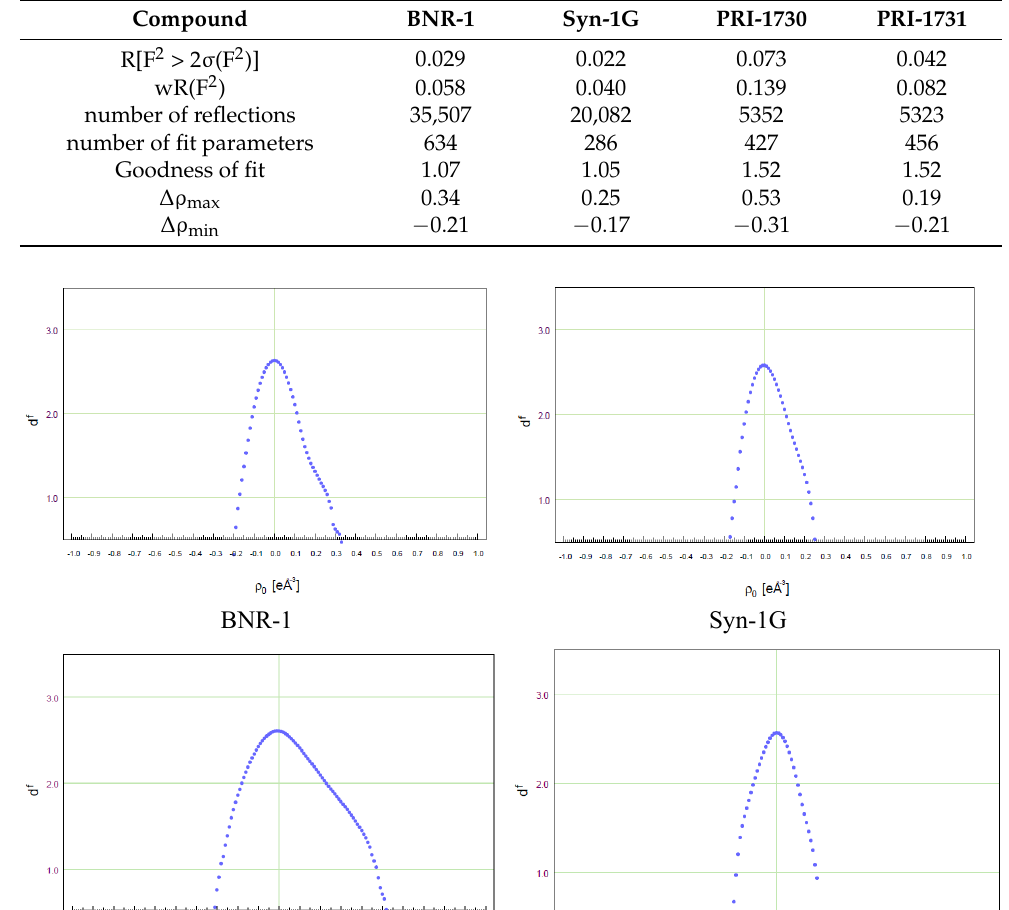
Table 1. Statistical parameters of MM refinements of BNR-1 and Syn-1G as well as TAAM refinements of PRI-1730 and PRI-1731.